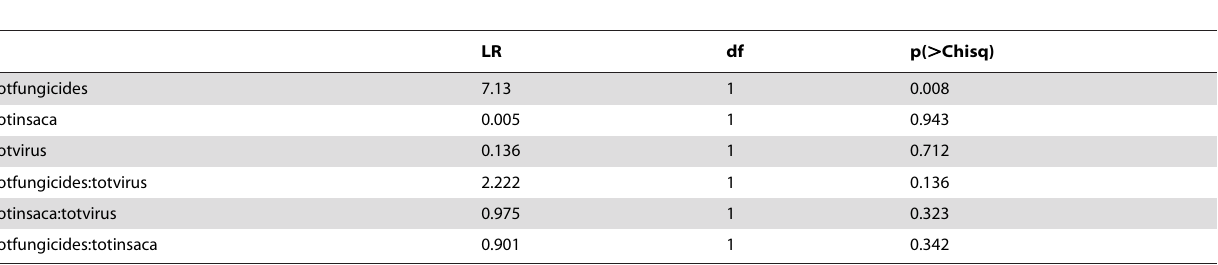
Table 5. Analysis of deviance table for generalized linear binomial models describing the relationships between the colony disorder probability and three variables: the total number of (1) fungicide residues (totfungicides), (2) insecticide-acaricide residues (totinsaca) and (3) virus detected for both visits (totvirus).